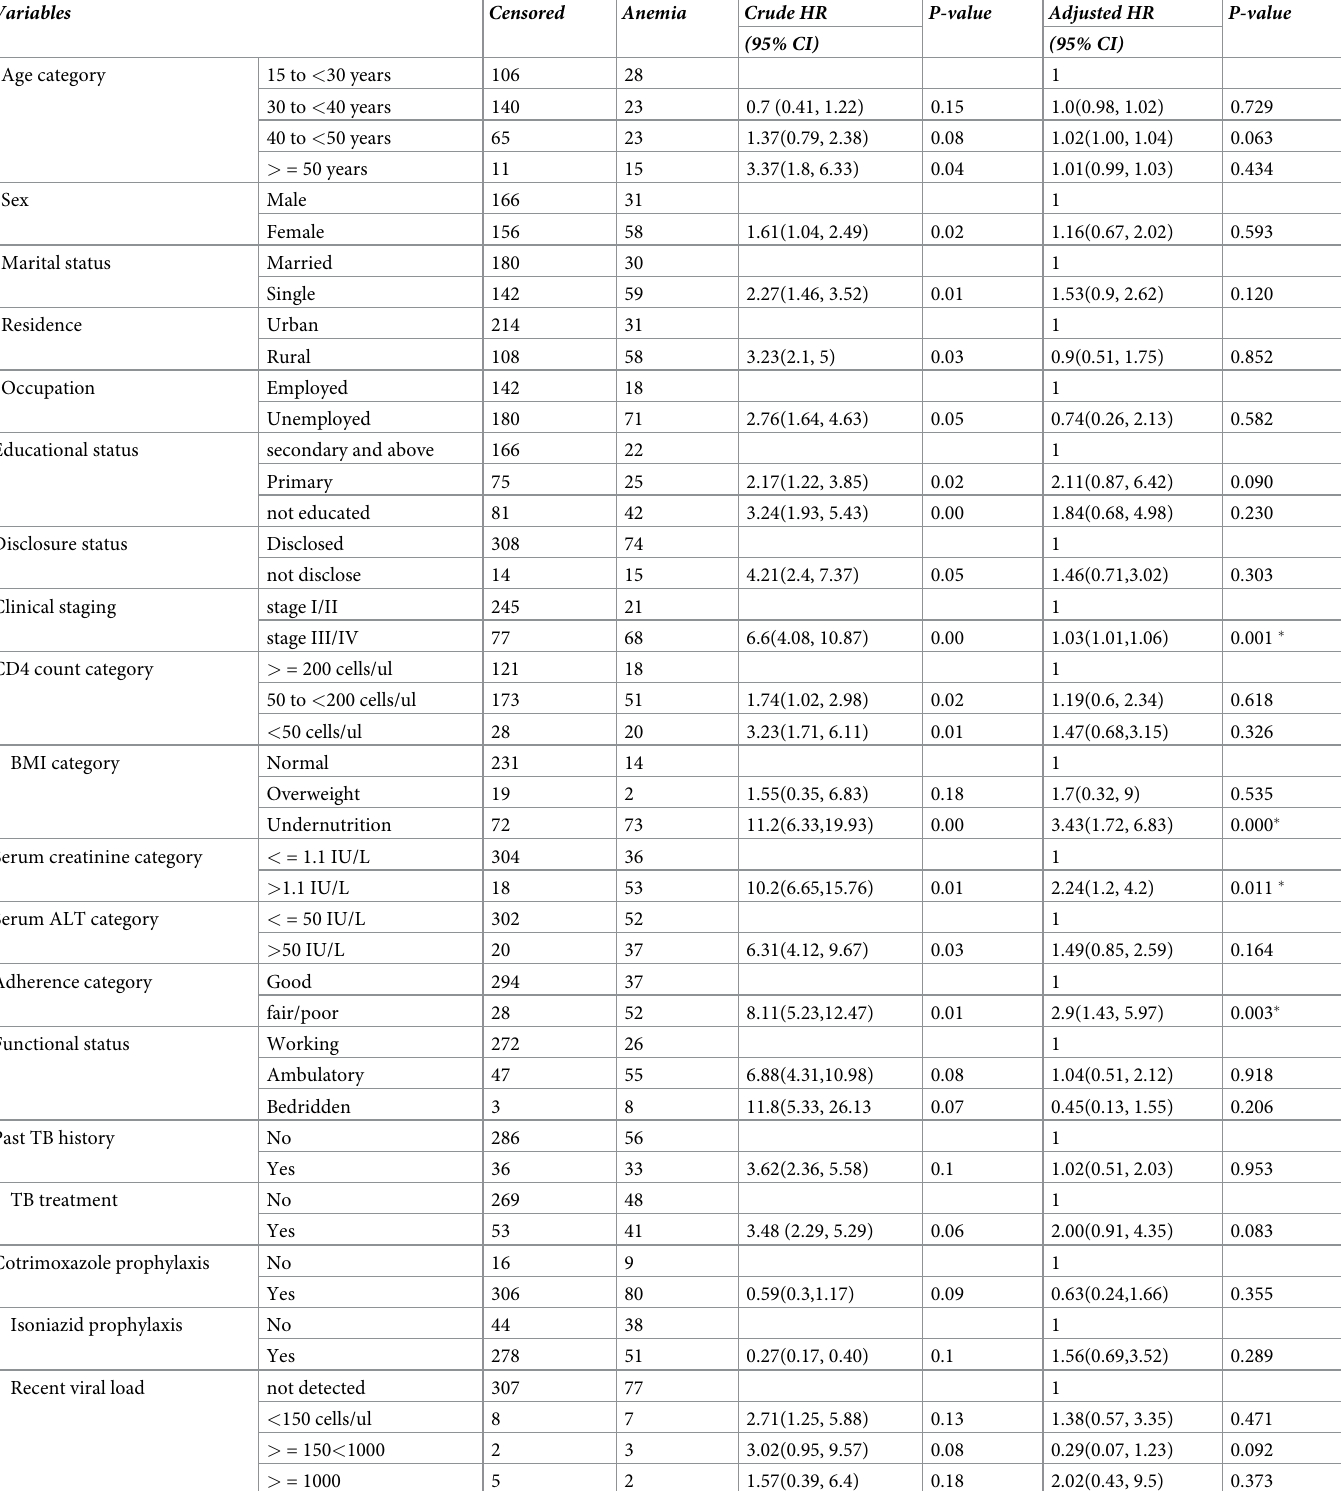
Table 3. Predictors of anemia among HIV positive adults on ART at Debre Tabor General Hospital, January 1, 2015 to December 30, 2019.